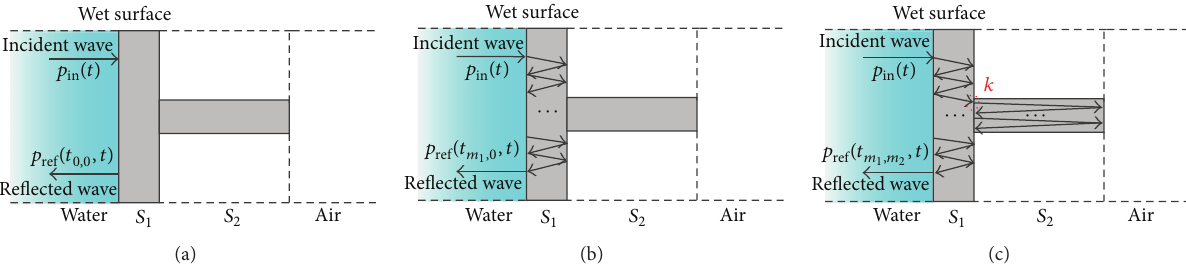
Figure 6: The wave propagation process in the panel with stiffener (T-shaped): (a) 𝑚 1 = 0 , 𝑚 2 = 0 ; (b) 𝑚 1 > 0 , 𝑚 2 = 0 ; (c) 𝑚 1 > 0 , 𝑚 2 > 0 .